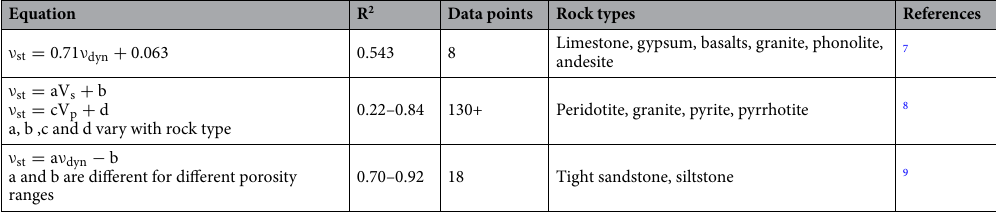
Table 1. Different empirical correlations between static and dynamic Poisson’s ratio.